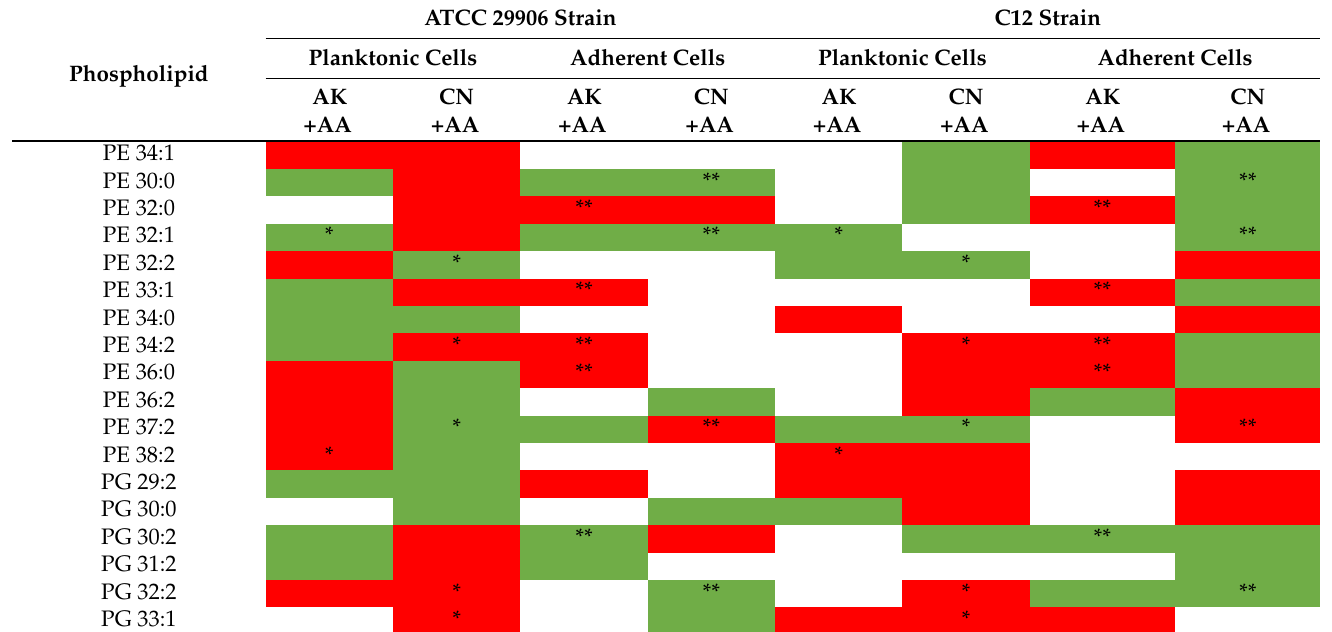
Table 3. Statistically significant changes in the PLs levels induced by combined treatment with ascorbic acid and amikacin or gentamicin in the planktonic and adherent cells of the P. mirabilis strains, determined by Student’s t